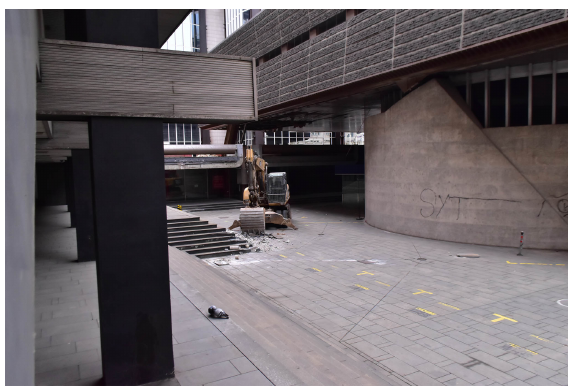
Figure 2. Demolition of Transgas